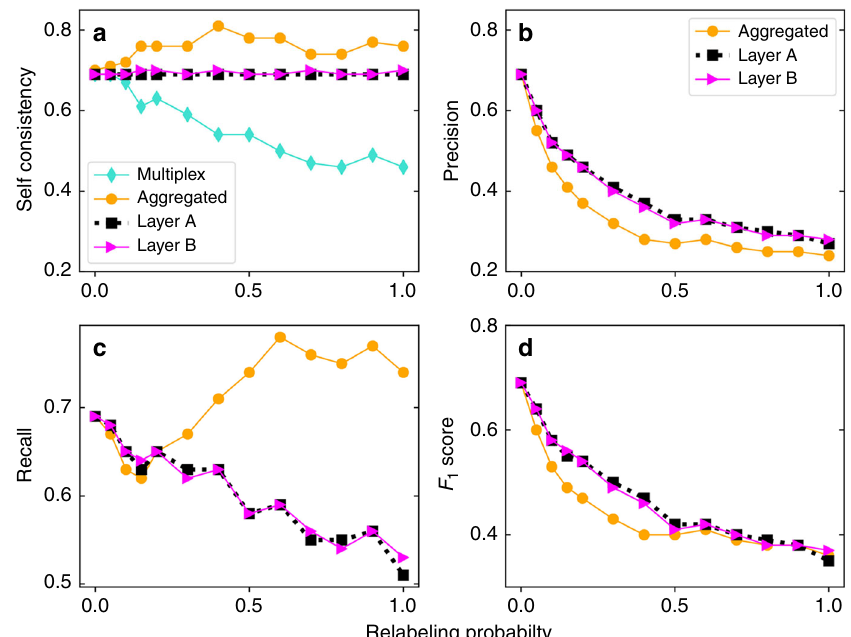
Fig. 4 Comparison between structural sets obtained for different network representations. We consider the multiplex networks described in Fig. 3 and the sets of SNs found for the multiplex and single-layer based representations of these networks. a As the set of SNs found in different instances of the optimization algorithm are different from each other, we fi rst quantify the self-consistency of those solutions across 100 independent runs of the SA algorithm. We then assume that the multiplex representation provides the ground-truth classi fi cation of the nodes. We compare the results of the other representations with the ground truth by measuring their precision b , their sensitivity or recall c , and their F 1 score